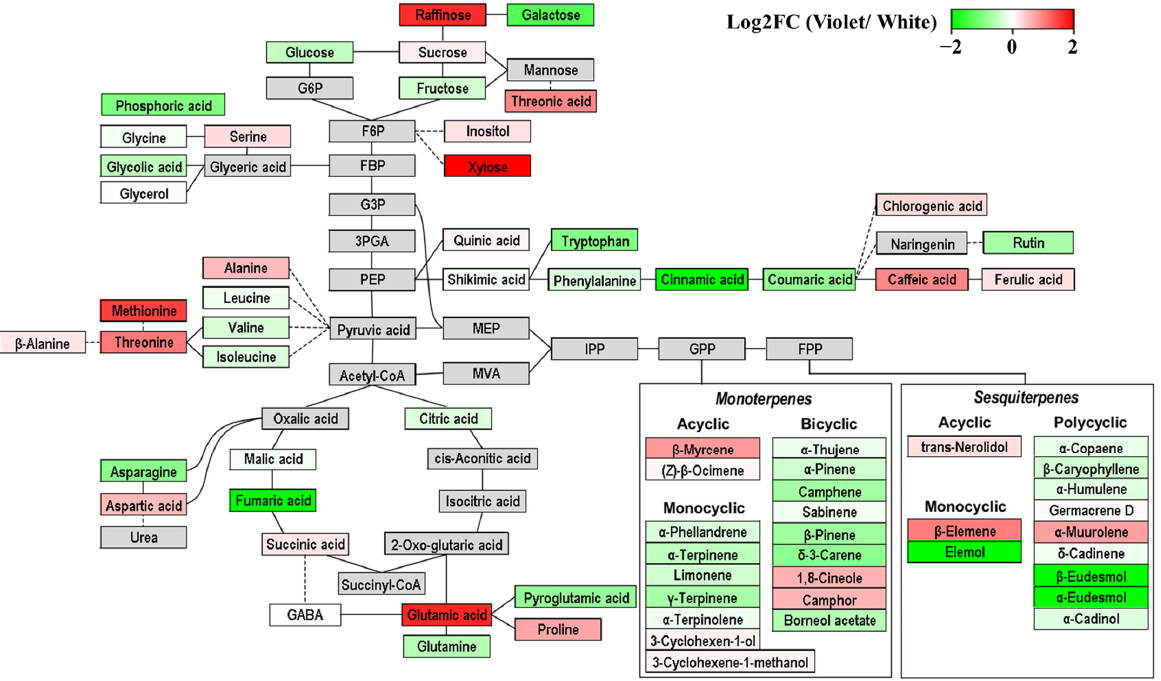
Figure 4. Metabolic pathway visualization and relative metabolite abundance of Magnolia flower buds. Fold changes (FC) from white to violet flower buds were converted into log2-transformed values (log2FC). A log2FC value range is − 2 < log2FC < 2. If log2FC value is higher than zero (indi- cated in red), metabolite content is higher in violet flower buds than in white flower buds. If log2FC value is less than zero (indicated in green), metabolite content is higher in white flower buds than in violet flower buds.